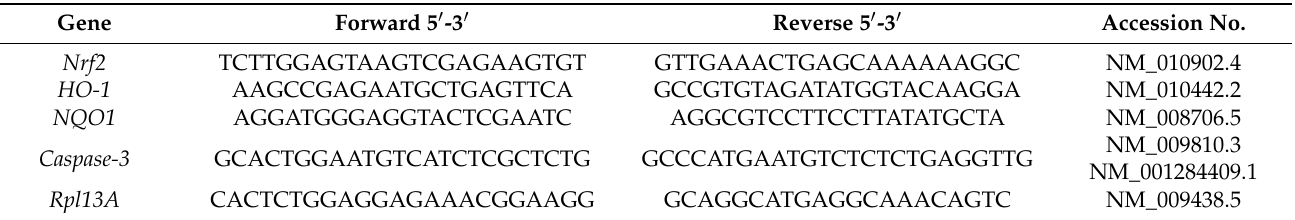
Table 1. Primer sequences used for